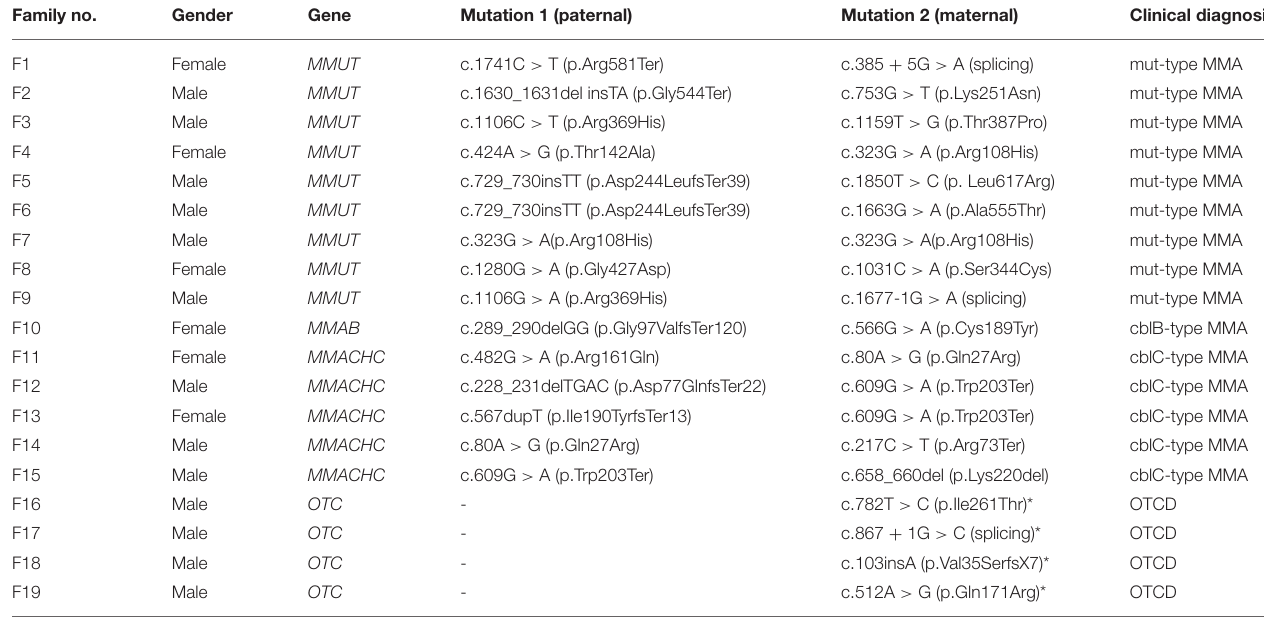
TABLE 1 | Gene mutations and clinical diagnosis of 19 probands. Family